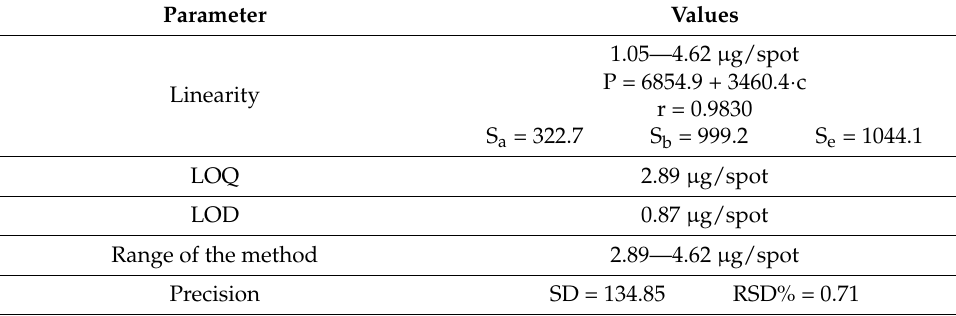
Table 1. Parameters of the method